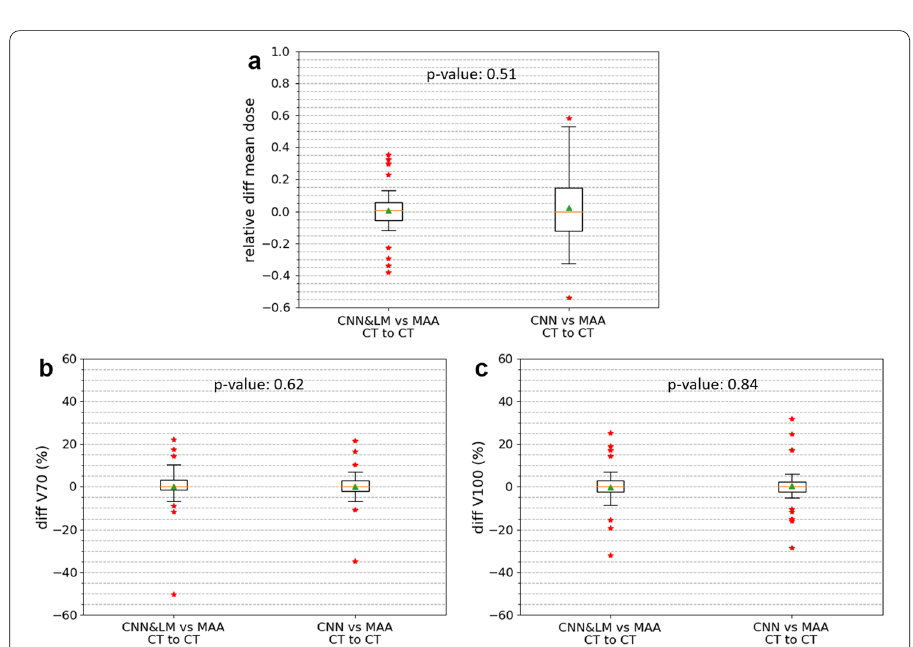
Fig. 9 Relative difference of mean dose ( a ) and difference of V70 ( b ) and V100 ( c ) between the reference and registered floating lesions using the CNN&LM-guided or CNN-guided CT to CT registration. MAA: the reference lesions. CNN&LM: the floating lesions registered by the CNN&LM-guided registration. CNN: the floating lesions registered by the CNN-guided registration. The relative difference of mean dose is computed by (mean dose (floating) – mean dose (reference)/mean dose (reference)). The difference of V70 and V100